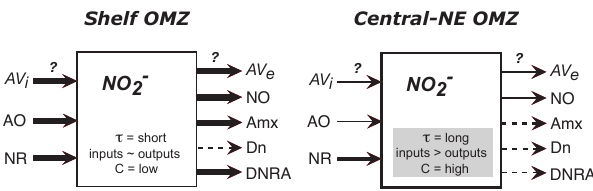
Fig. 5. A conceptual diagram illustrating that in the central-NE Ara- bian Sea OMZ, total NO − influx via NO − reduction (NR) and to 2 3 a lesser extent NH 3 oxidation (AO), likely exceeds the combined NO − losses via mainly NO − oxidation (NO), and perhaps some 2 2 low/intermittent (dashed arrows) anammox (Amx), dentrification (Dn) and dissimilatory nitrite reduction to ammonium (DNRA). The resultant slow accumulation, along with probably a long wa- ter residence time ( τ ), results in high NO − concentrations (C) in the 2 central-NE OMZ. In comparison, despite the apparently higher in- put rates detected over the shelf (thicker arrows of AO and NR), the similarly high outputs seem to roughly balance the high total in- puts, thus maintaining a low NO − concentration in the shelf OMZ. 2 Because no convincing evidence has been found to unambiguously confirm denitrification in the current study, this is shown here as dashed arrows to indicate its possible potentials only. Also shown in this diagram are the advective influxes (AV i ) and outfluxes (AV e ) , which are postulated to be greater over shelf regions (thus shorter τ therein) than in the central-NE OMZ; but they have not been as- sessed in the current study (as indicated by